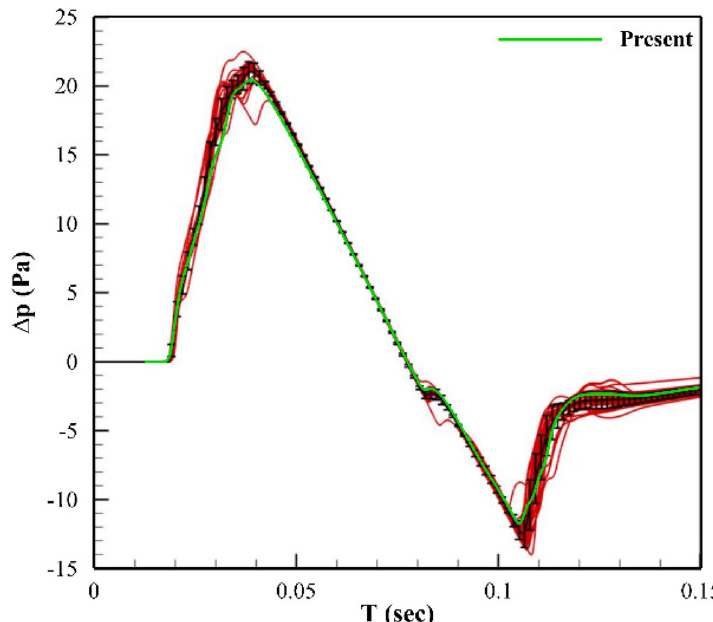
Fig. 9 Comparison between far-field ground signature and SBPW-3 data